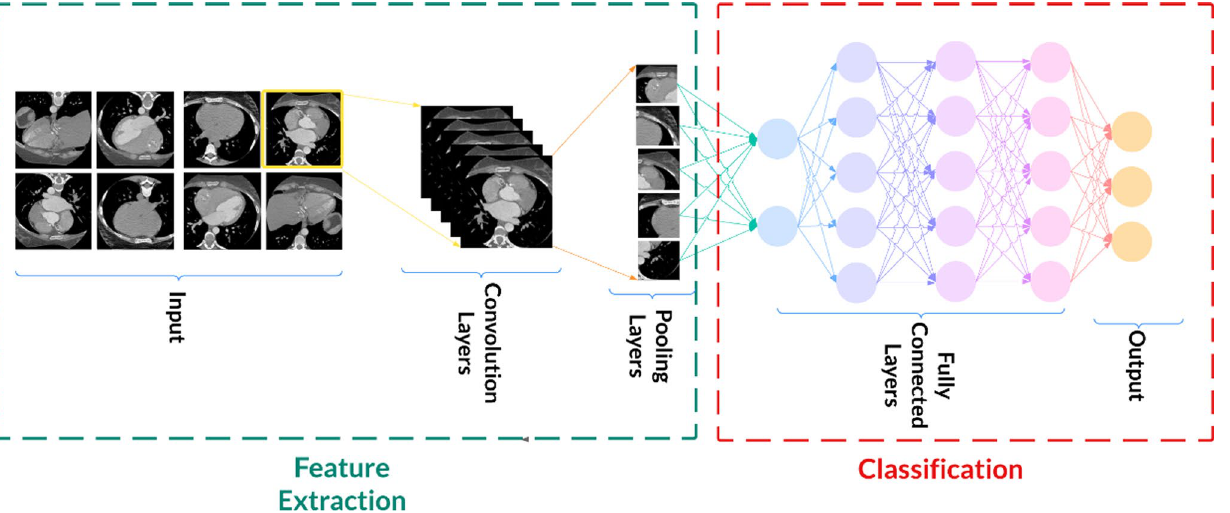
Fig. 3 The DL model (CNN) structure for classification of brain disease using brain CT scan images as input